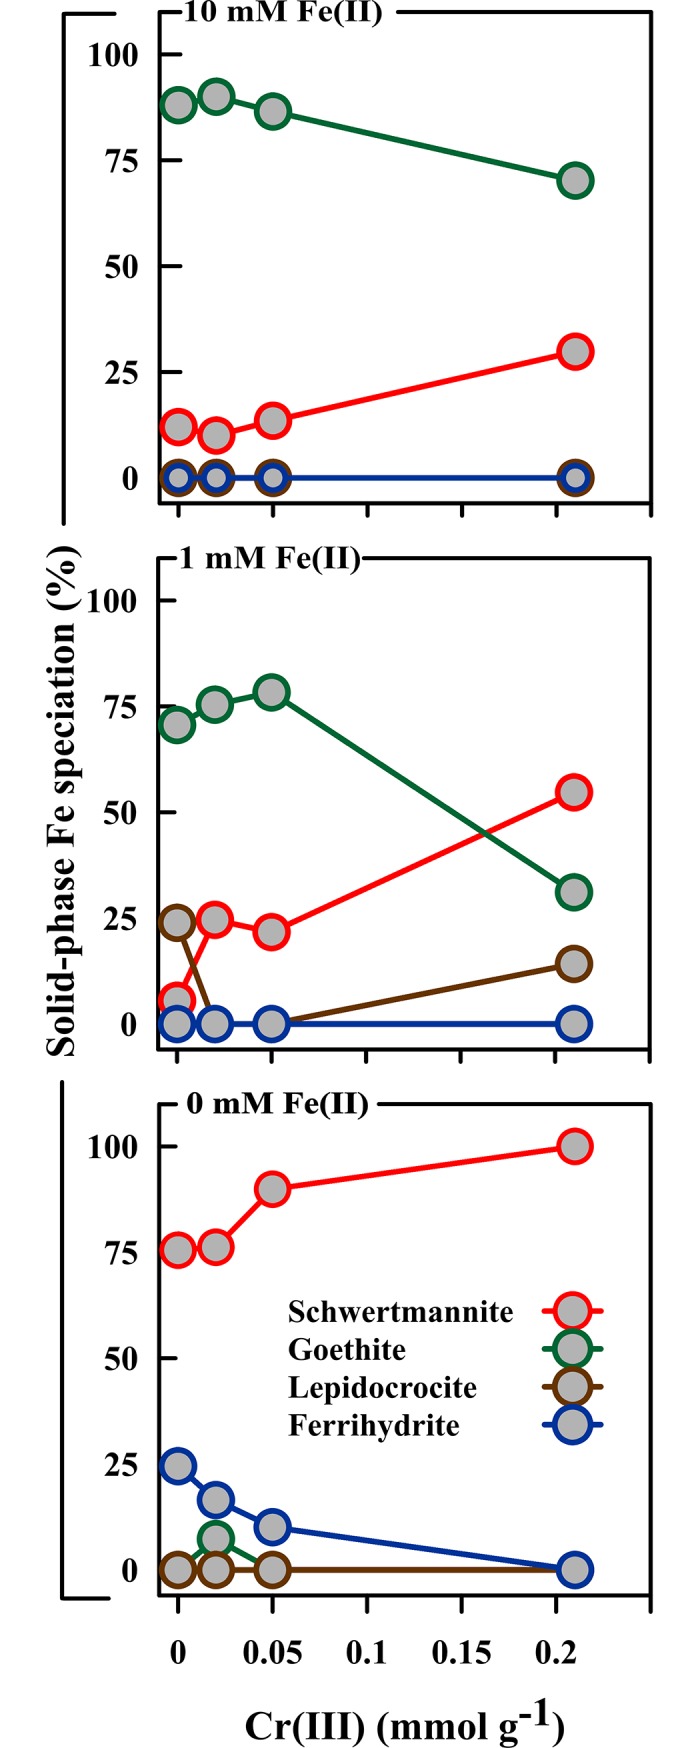
Solid-phase Fe speciation (based on Fe K-edge EXAFS spectroscopy) after allowing schwertmannite, with varying levels of Cr(III)-substitution, to react with 0, 1 and 10 mM Fe(II) for 14 d.